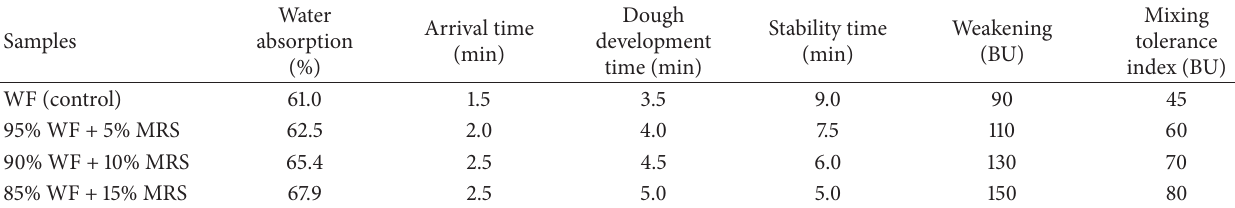
Table 4: Farinograph parameters of dough prepared from different formulas.